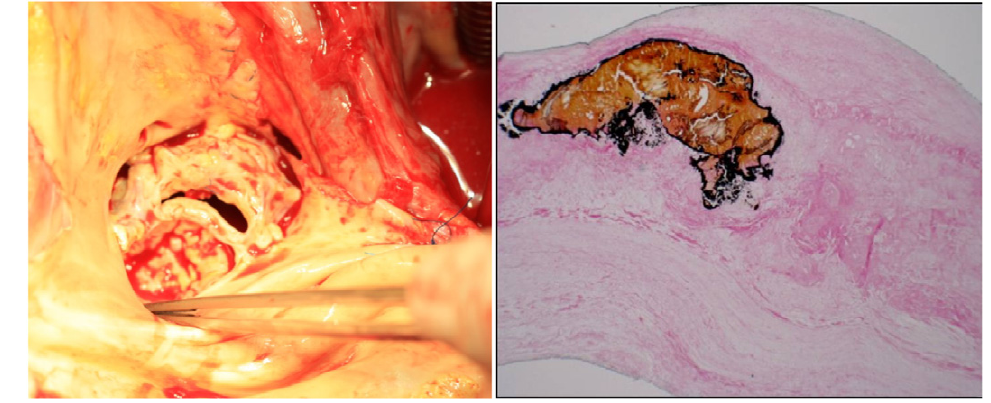
Table 1. Comparative expression of inflammatory cells and mediators in patients with aortic stenosis and aortic insufficiency (from Toutouzas et al. reference [16]. AVS (n = 75) AVI (n = 21) Grade Histological features T lymphocytes